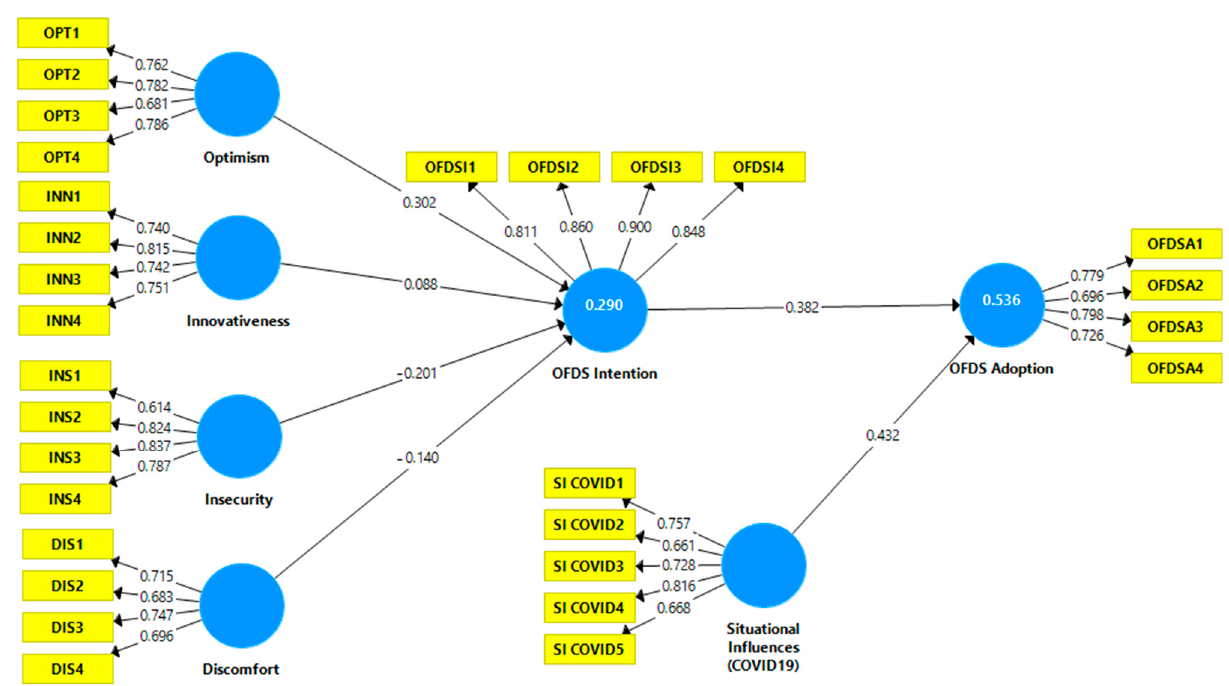
Figure 1. Measurement model (Partial least square (PLS)-algorithm).